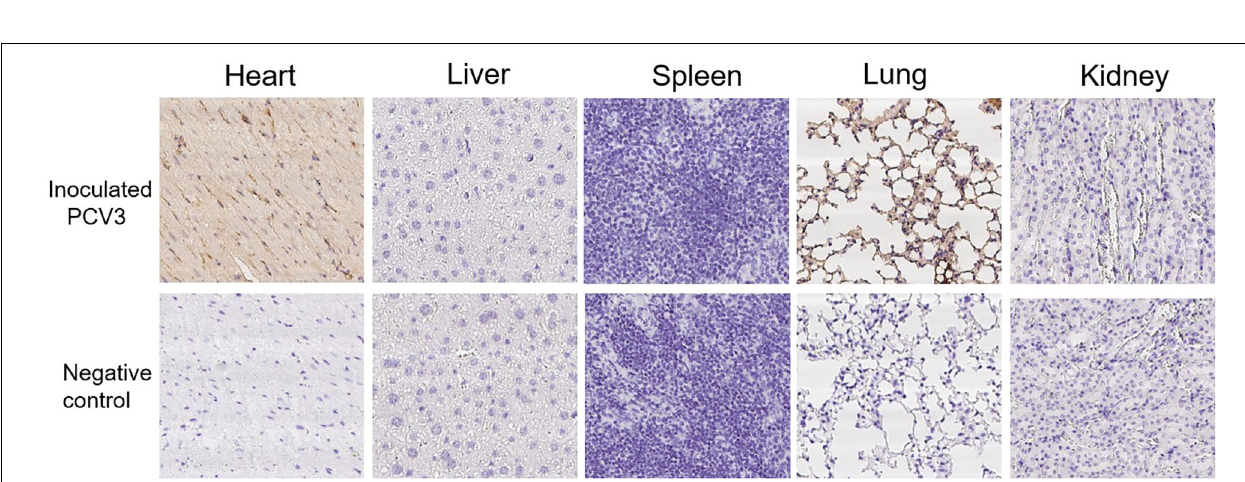
Frontiers in Microbiology |